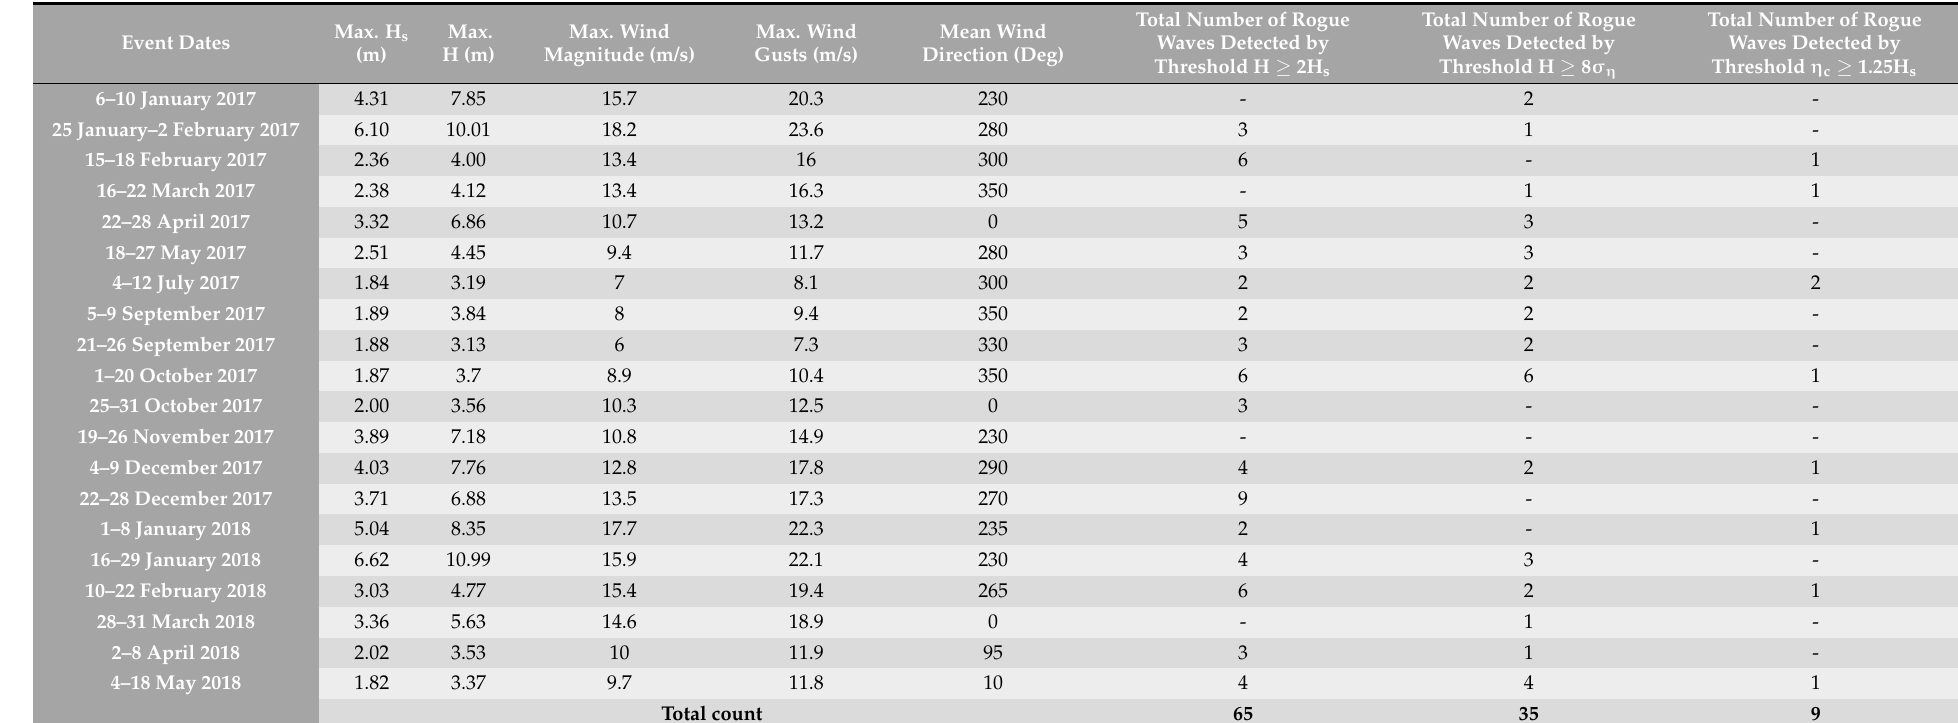
Table 1. All selected high sea events and their main